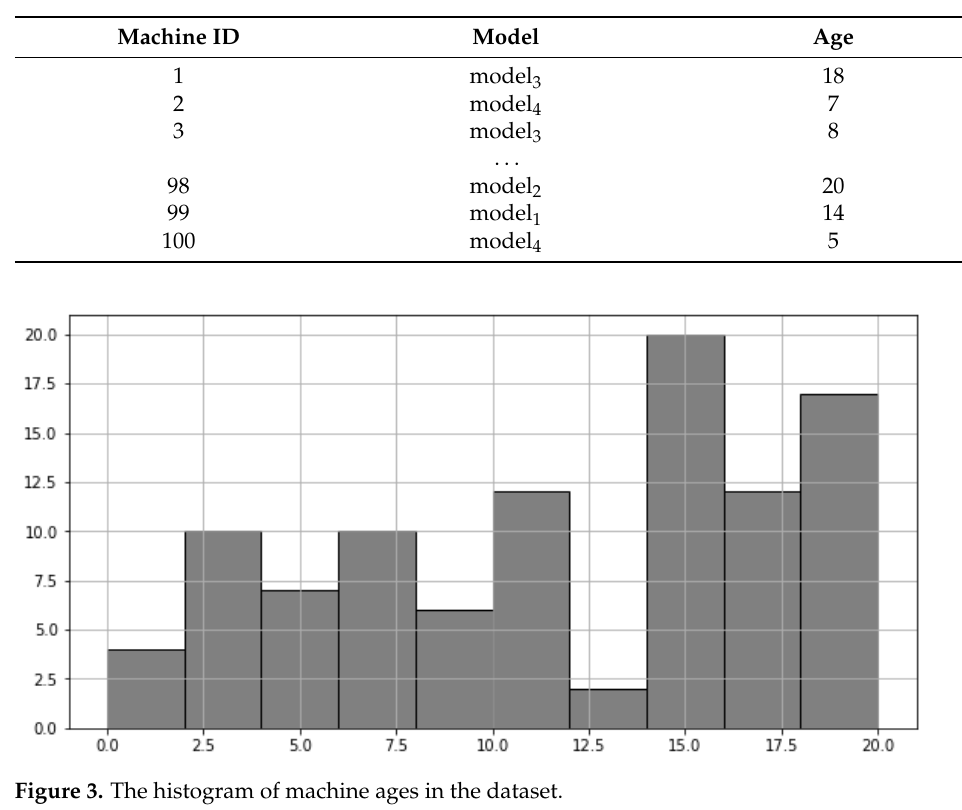
Table 1. Machine model and age data.